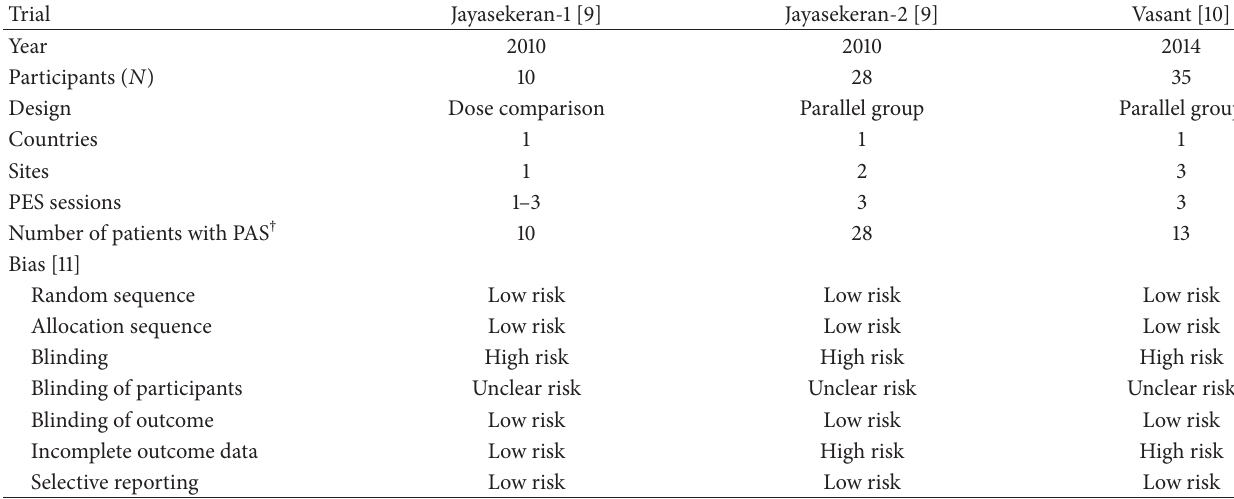
Table 1: Design characteristics of completed trials of electrical pharyngeal stimulation in patients with recent stroke and